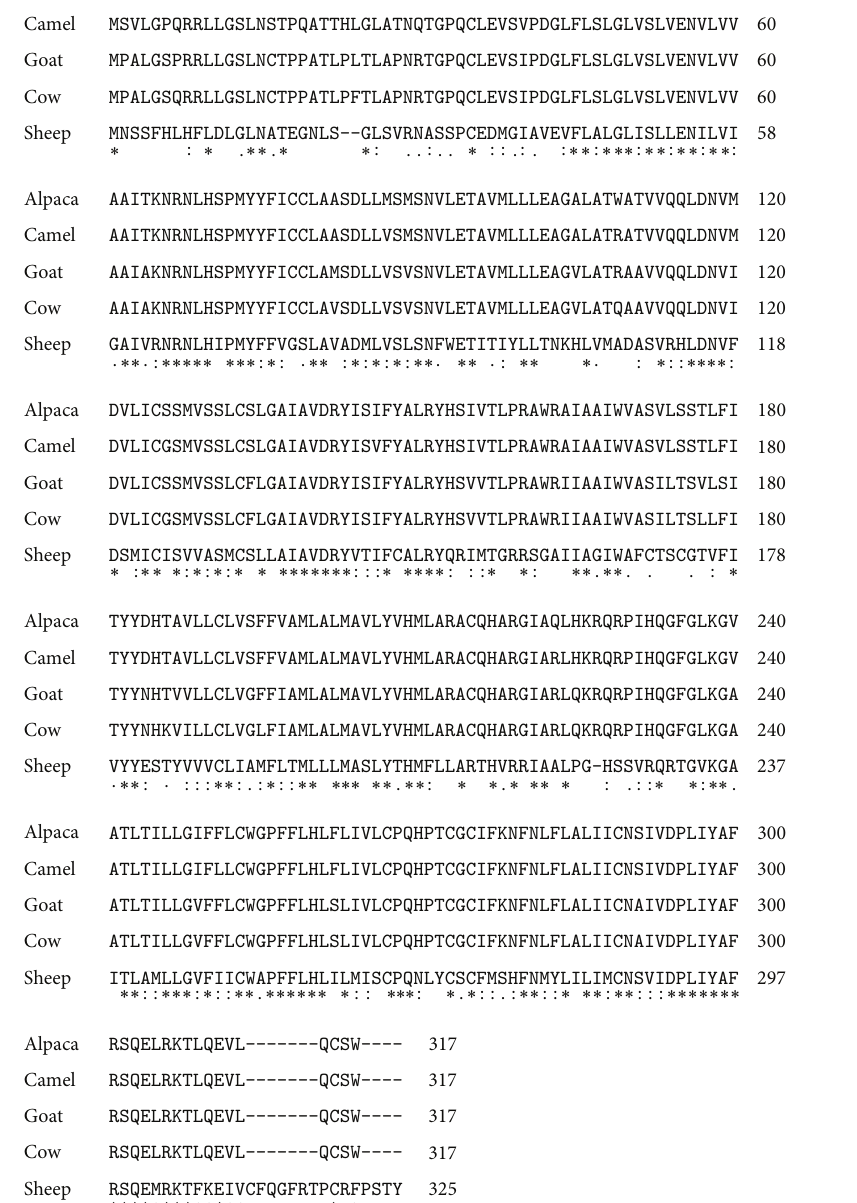
and low in white (0.38 ± 0.04) skin biopsies (Figure